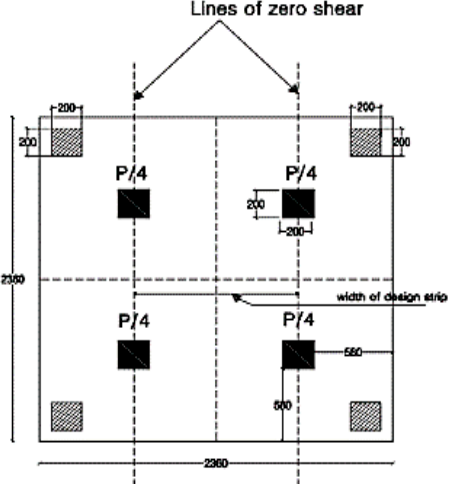
Figure 13. Design strip for model calibration.